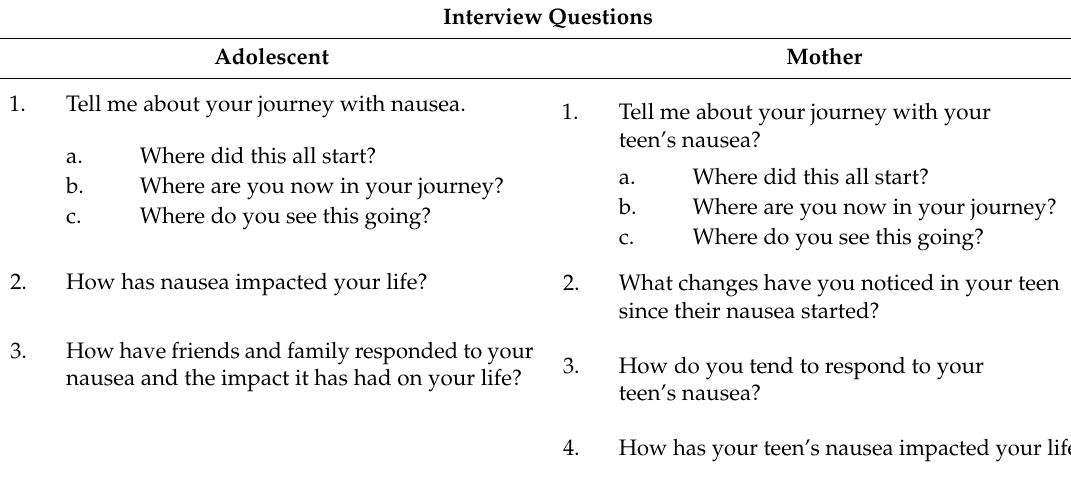
Table 1. Semi-Structured Qualitative Interview